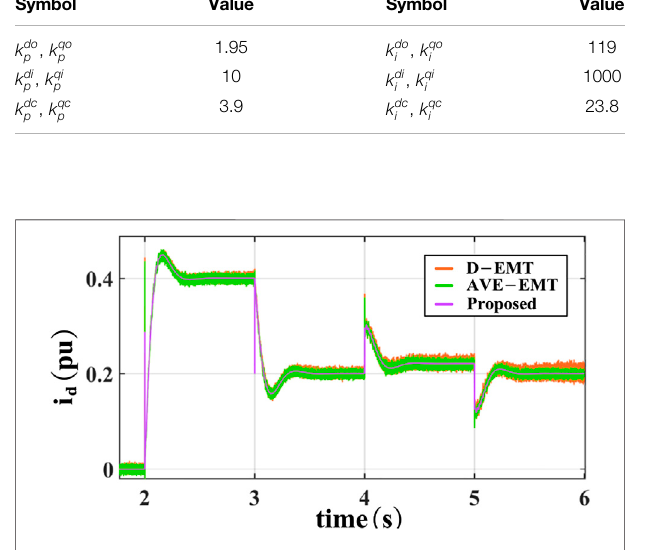
FIGURE 10 | Per-unit waveform of i d .